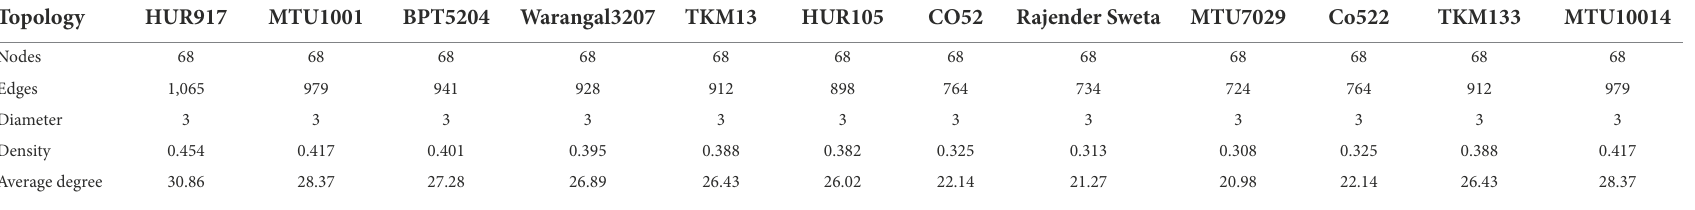
TABLE 2 Global network property of rhizo-microbiome of rice